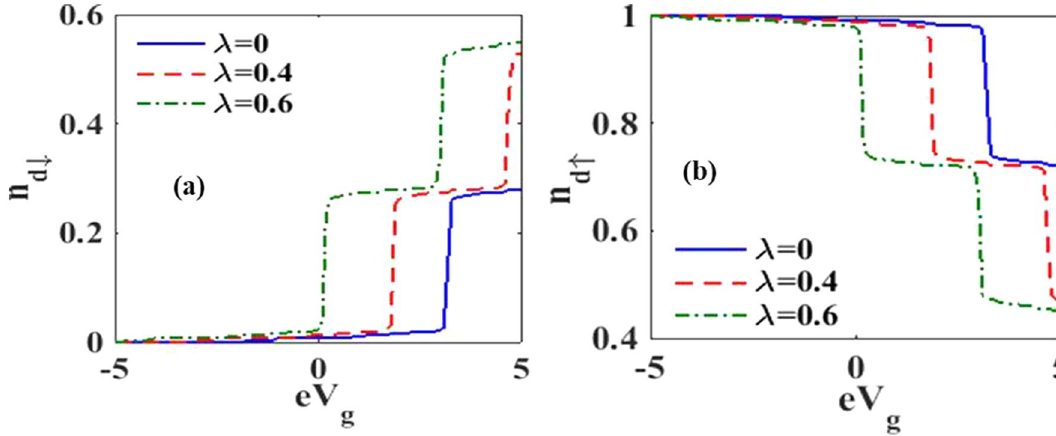
Figure 2. Dot occupancy versus gate voltage for different values of e–p interaction strengths.